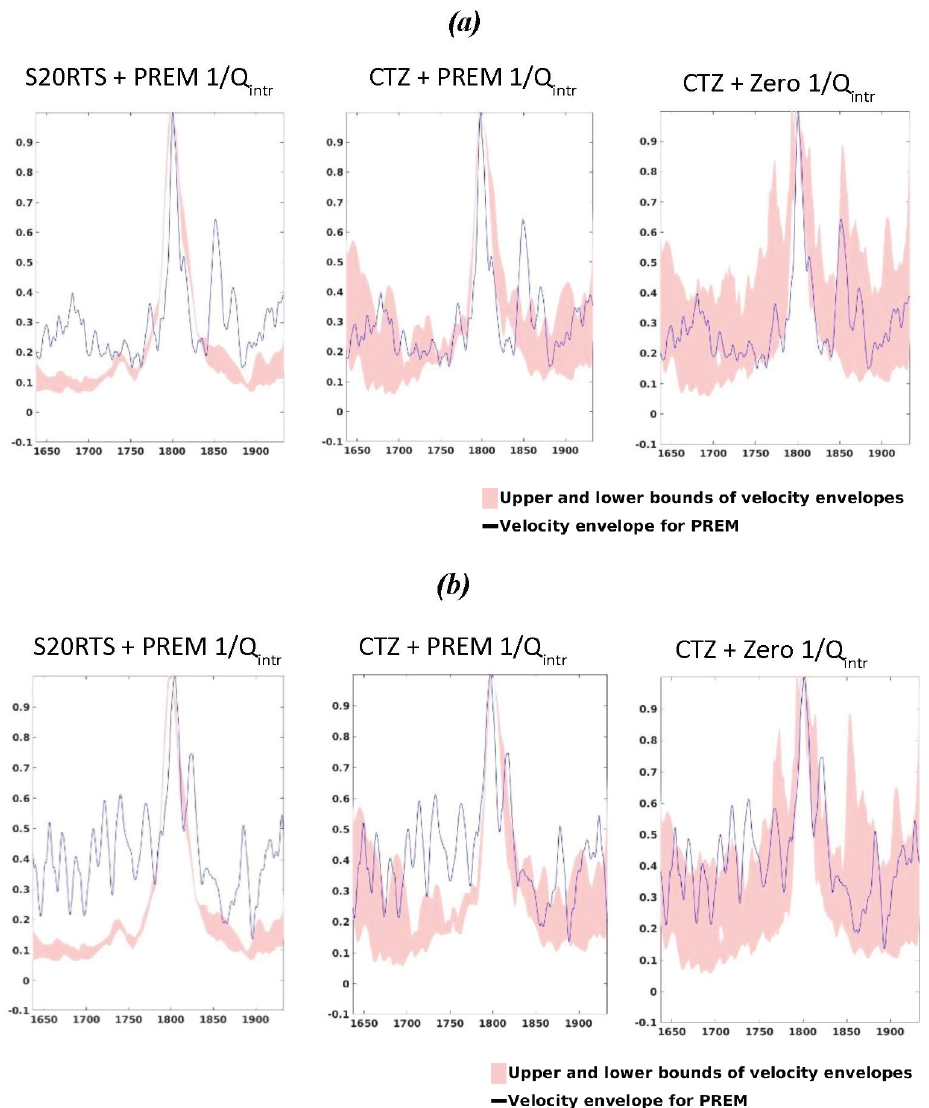
Figure 8. Upper–lower bounds of coda envelopes (shaded area) calculated from five random heterogeneity realizations of MODEL 2 (left), MODEL 4 (middle) and MODEL 5 (right), compared to the squared velocity envelopes of data traces (solid blue lines) from (a) Papua New Guinea data and (b) the eastern China–Russia border